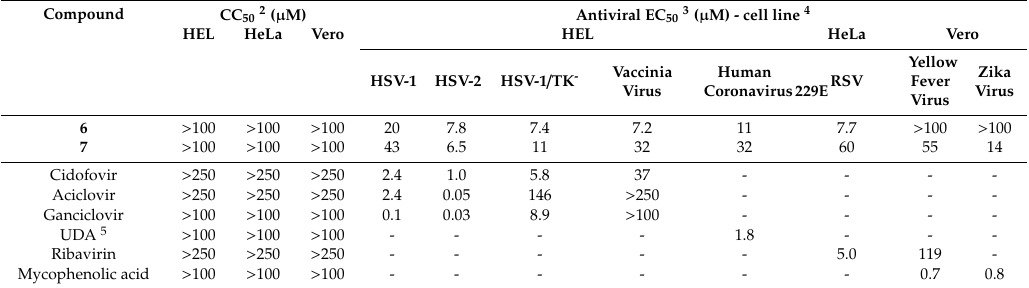
1 Viruses: herpes simplex virus type 1 (HSV-1) or type 2 (HSV-2); a thymidine-kinase deficient (TK - ) mutant of HSV-1; vaccinia virus; human coronavirus 229E; respiratory syncytial virus (RSV); yellow fever virus and Zika virus. 2 50% Cytotoxic concentration, assessed in mock-infected cells by the MTS cell viability assay. 3 50% Effective concentration offering 50% protection against virus-induced CPE, as determined by the MTS assay. 4 Cell lines: HEL, human embryonic lung fibroblast cells; HeLa, human cervix carcinoma cells; Vero, African Green monkey kidney cells. 5 UDA: Urtica dioica agglutinin lectin; for this compound, concentrations are expressed in µg/mL.